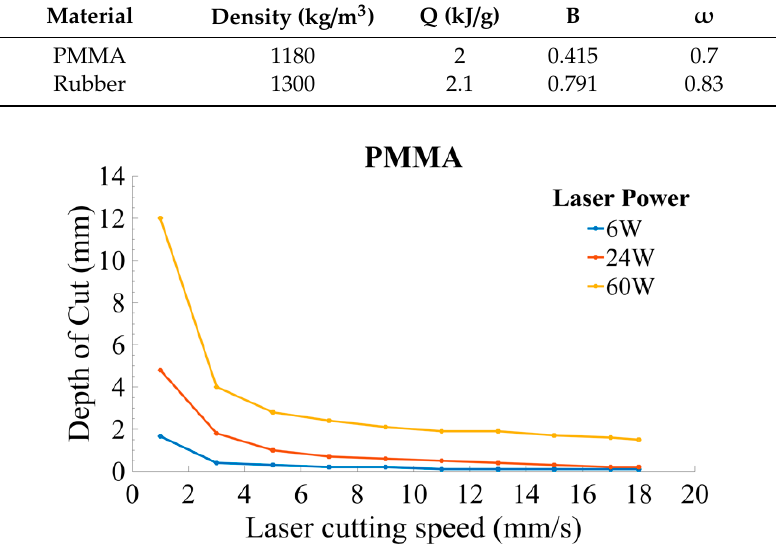
Figure 10. Parametric trends for CS and depth of cut (DOC) at different power ratings in PMMA [46].